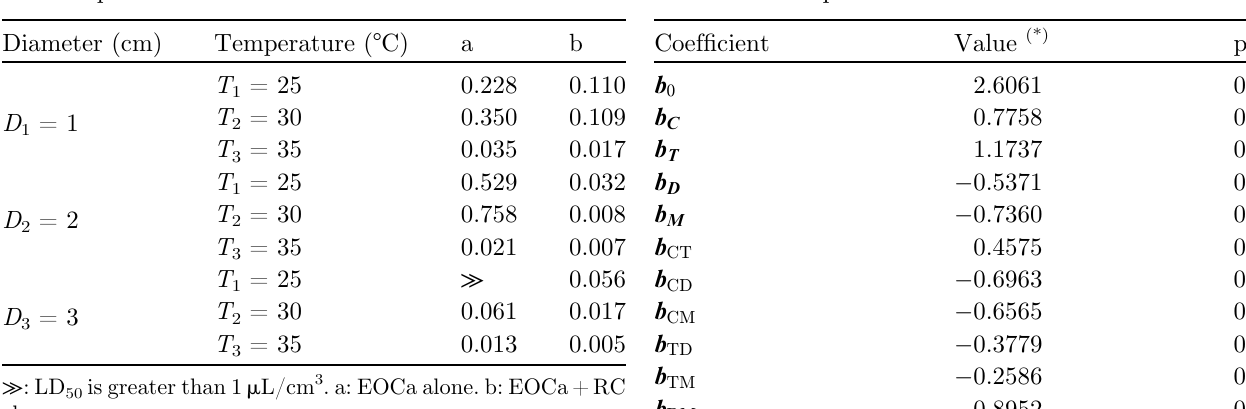
Table 4. LD of the insecticidal activities of the EOCa 50 fi xed on porous media.